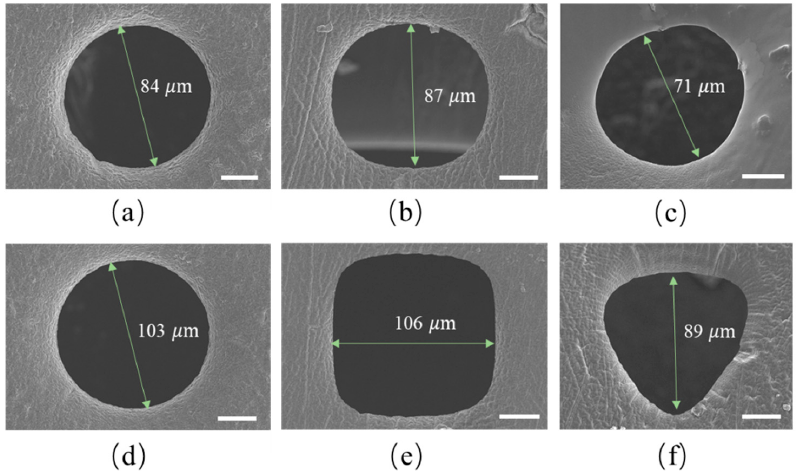
Figure 9. The 3D printing results of the hole features. ( a ) the designed pattern for the circular hole, ( b ) the designed pattern for the square hole, ( c ) the designed pattern for the triangular hole, ( d ) the optimized pattern for the circular hole, ( e ) the optimized pattern for the square hole, ( f ) the optimized pattern for the triangular hole. scale bar: 25 µm.